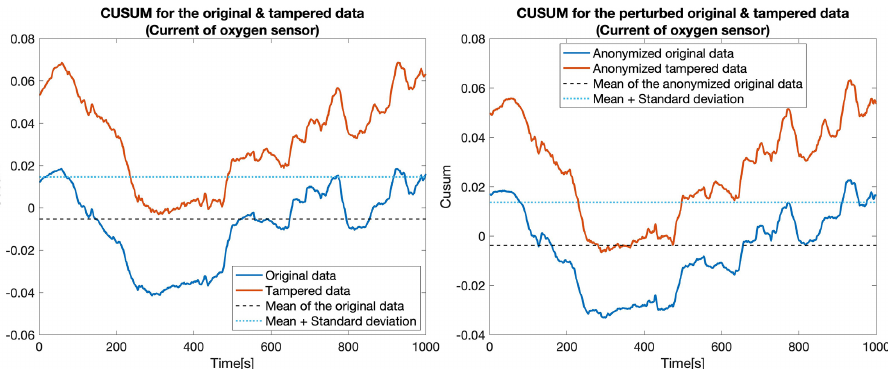
Figure 5. CUSUM for the original data (blue) and tampered data (orange) for the Current of oxygen sensor